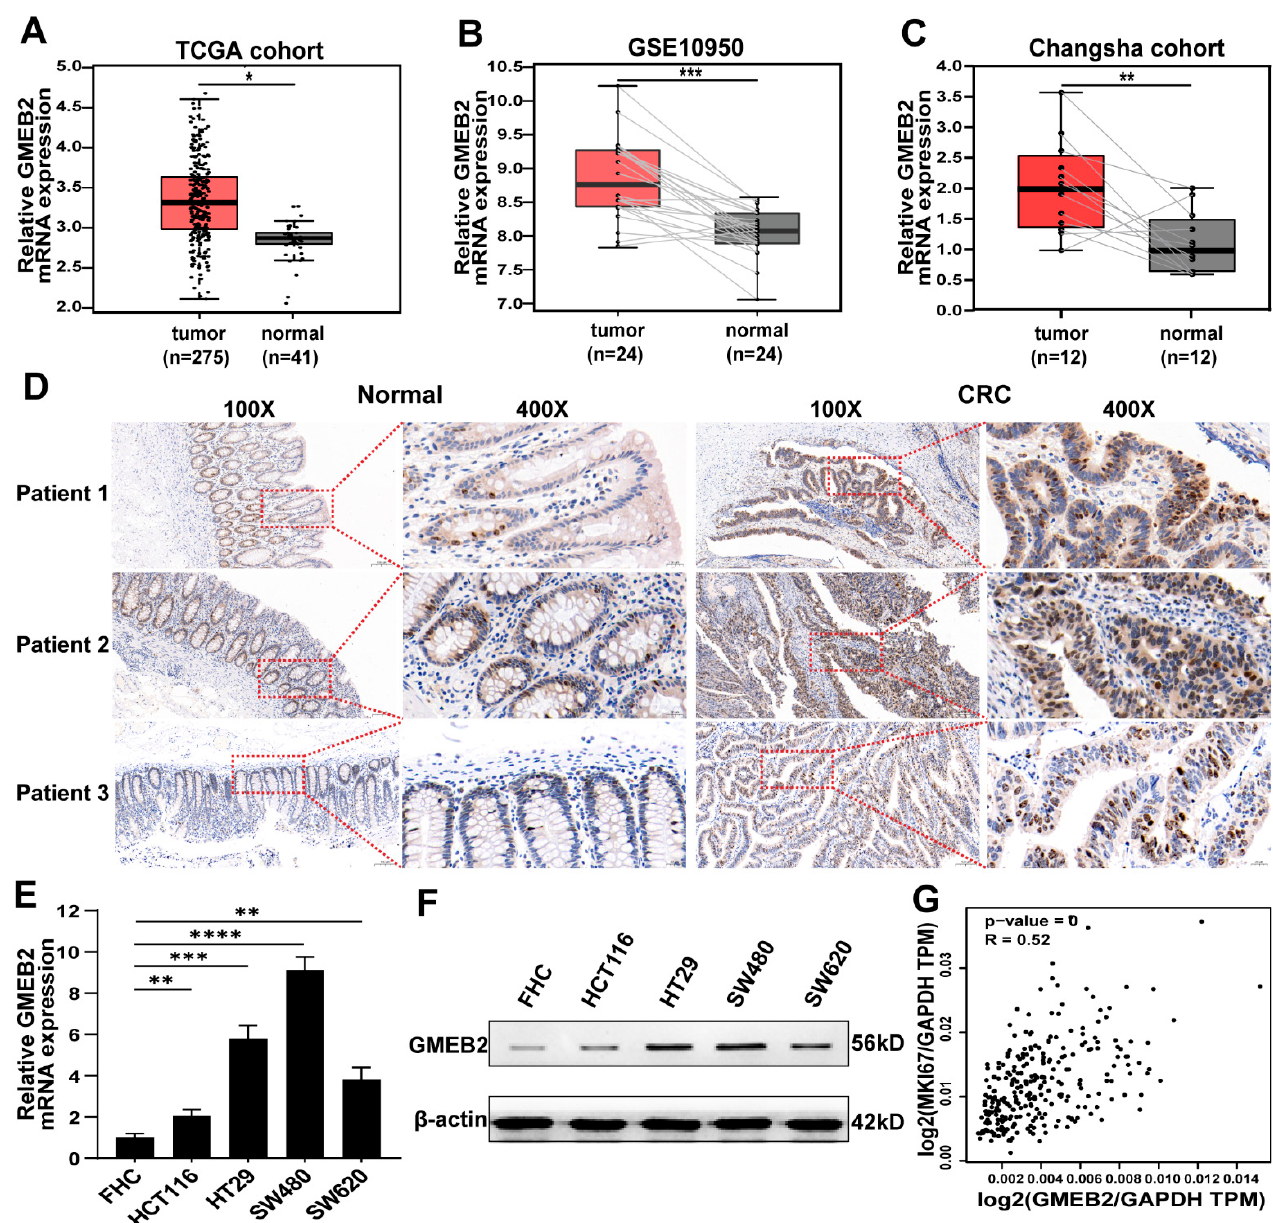
Figure 1. The mRNA and protein expression levels of GMEB2 in CRC. ( A ) GMEB2 mRNA level in the TCGA database (Student’s t -test, * p < 0.05). ( B ) GMEB2 mRNA level in GSE10950 of the GEO database (paired Student’s t -test, *** p <0.001). ( C ) GMEB2 mRNA levels in 12 pairs of CRC and paracancerous tissues from patients (paired Student’s t -test, ** p < 0.01). ( D ) GMEB2 protein levels in 3 pairs of CRC and paracancerous tissues from patients measured by IHC. Scale bar, 20 µ m